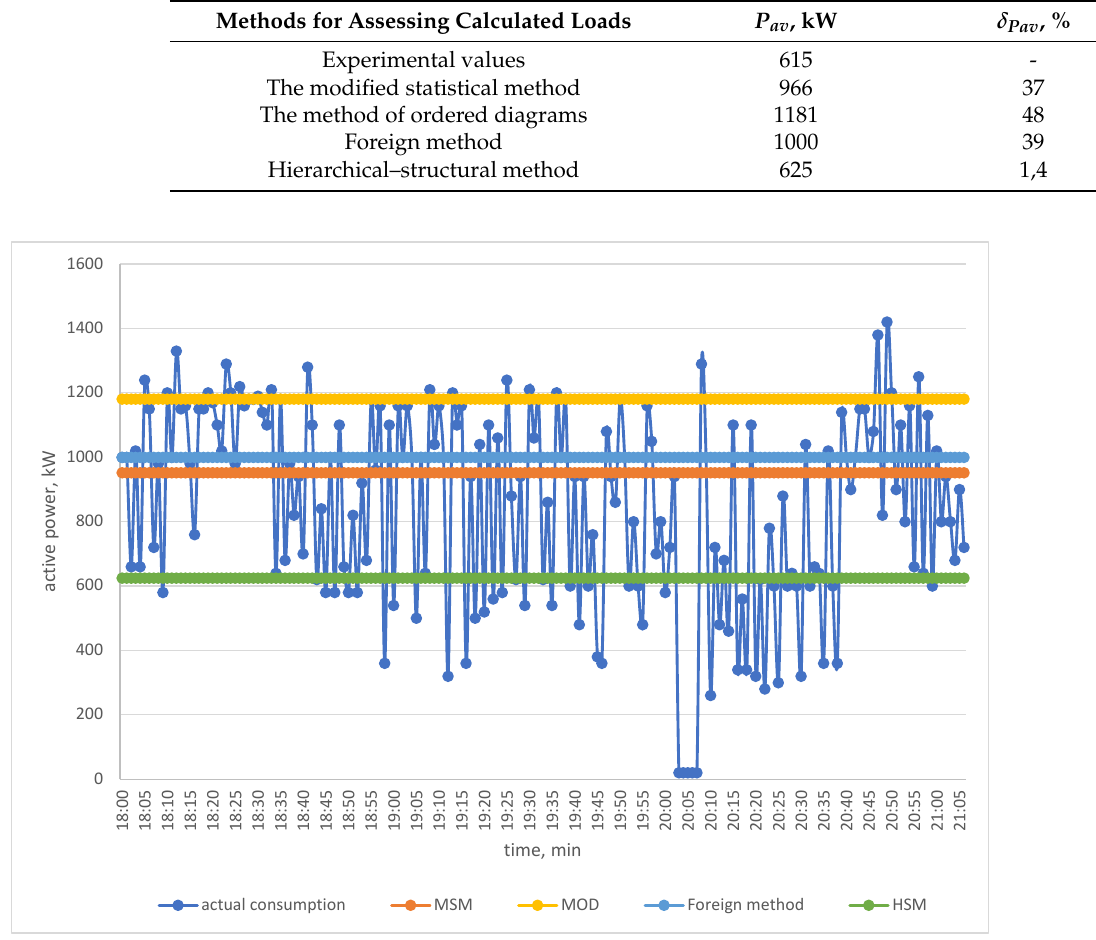
Figure 12. Actual values for the electrical load curves and the calculated values for the average load power.